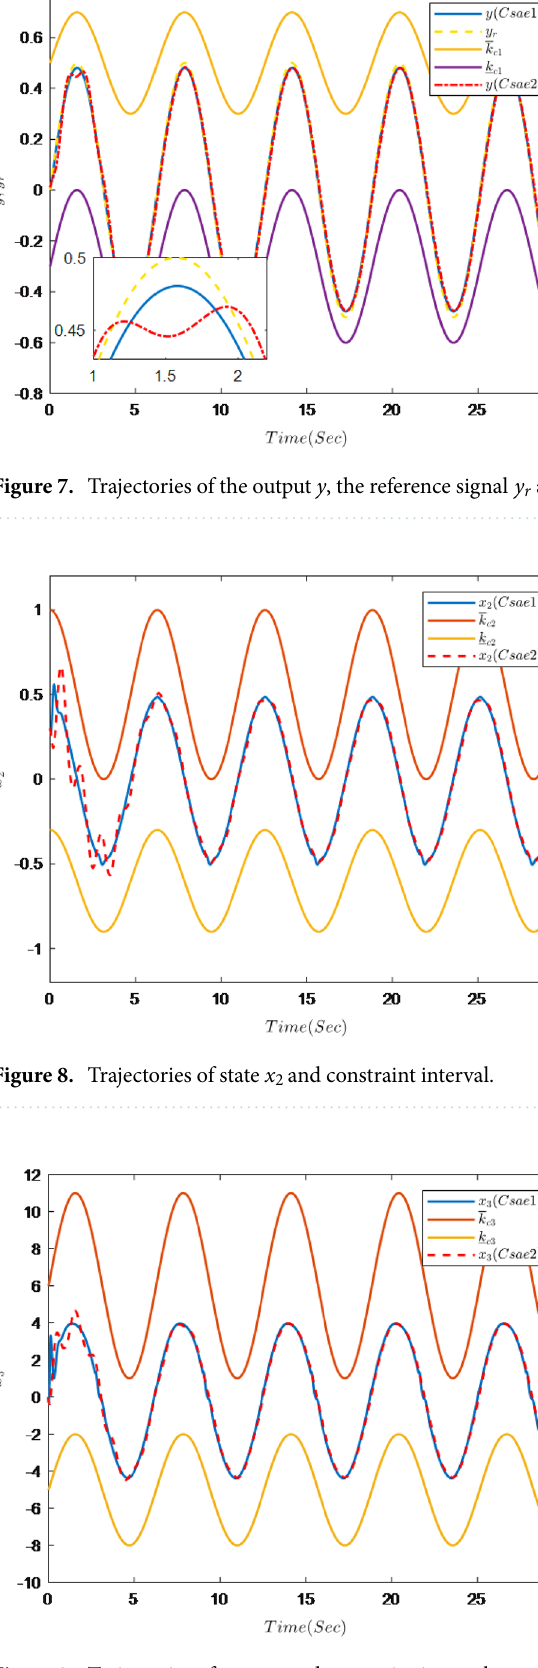
Figure 9. Trajectories of state x 3 and constraint